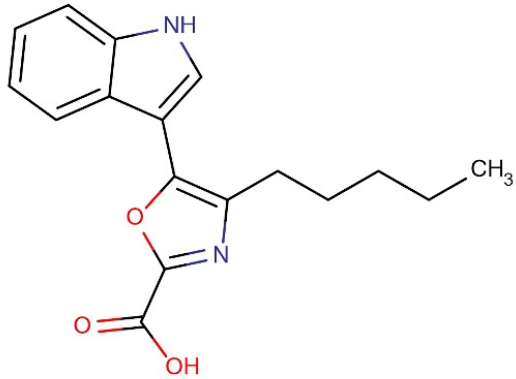
Figure 6. Structure of the ethyl acetate fraction containing the novel compound 5-(1 H -indol-3-yl)-4- pentyl-1,3-oxazole-2-carboxylic acid.